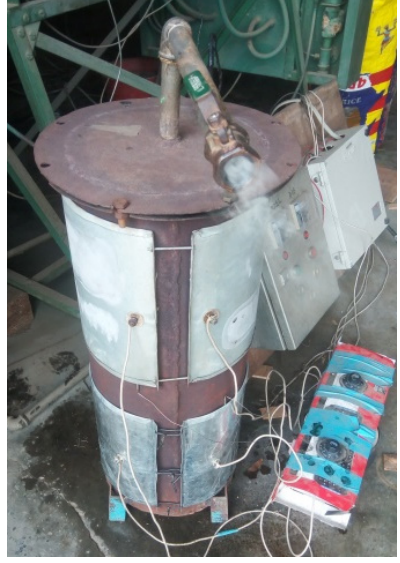
Figure 1. The torrefaction reactor.